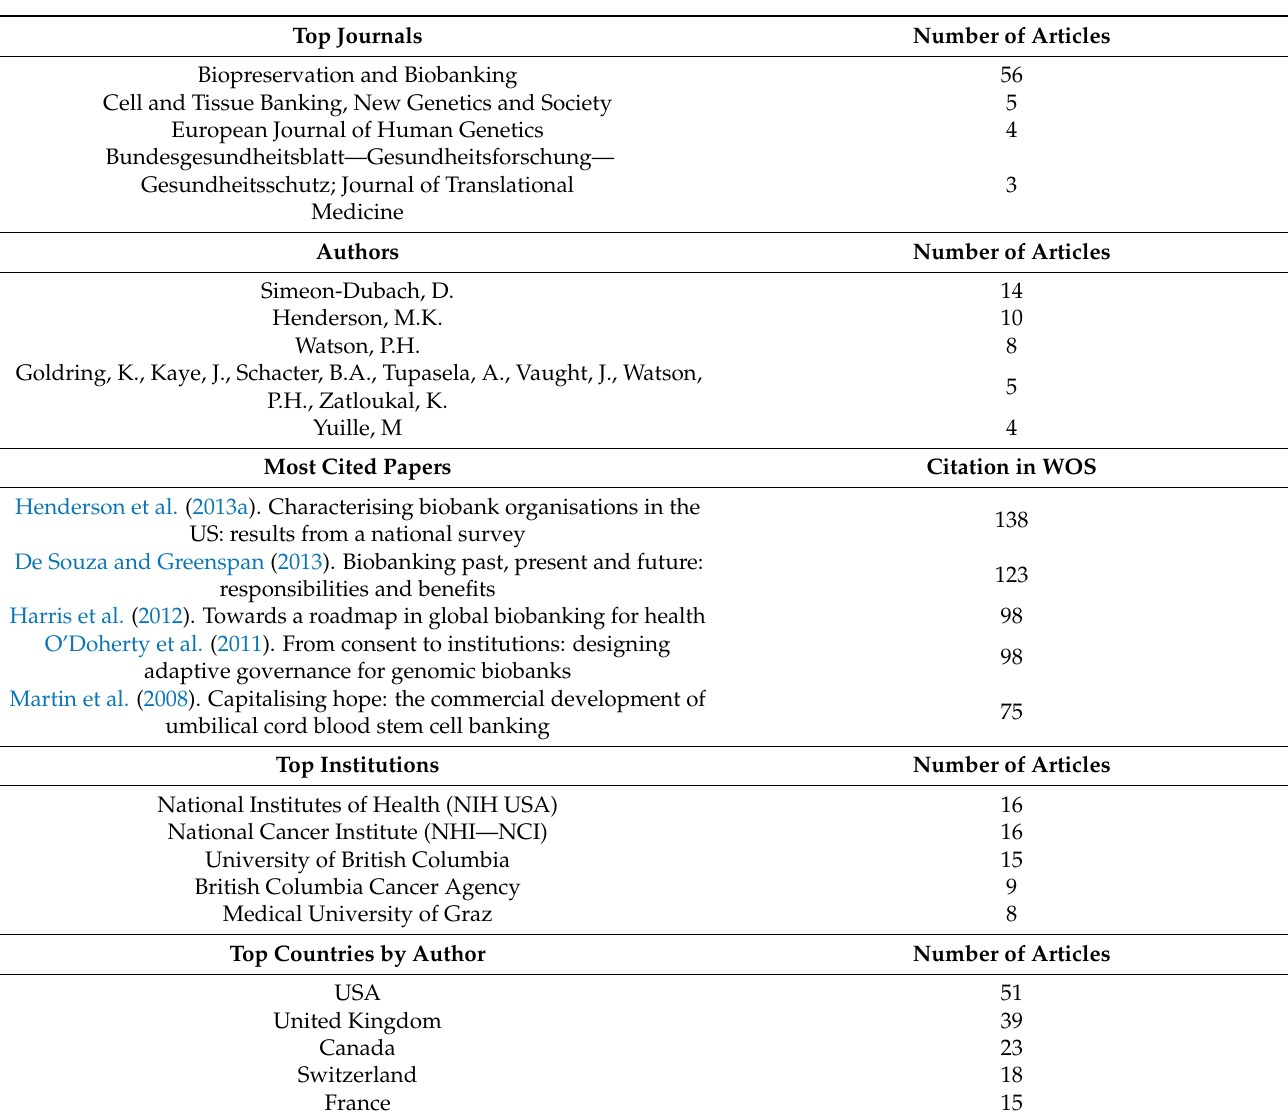
Table 1. Top journals, authors, papers, institutions and